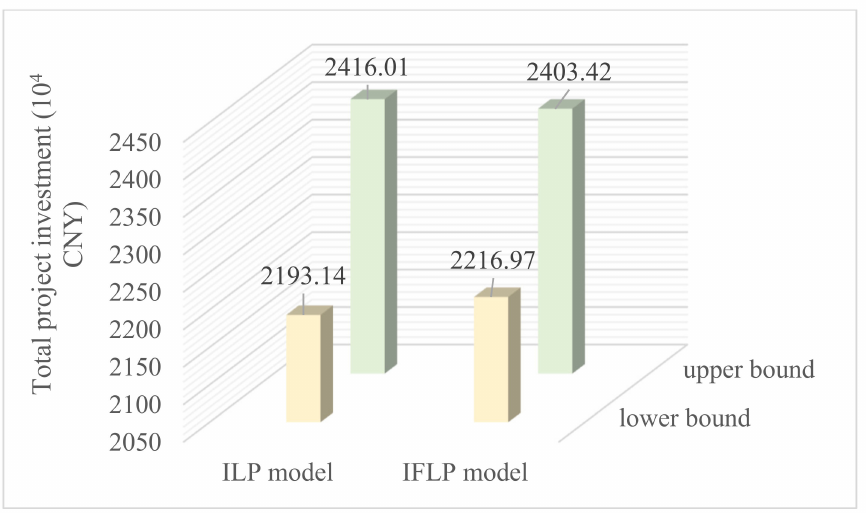
Figure 5. Comparison of total project investment through ILP and IFLP